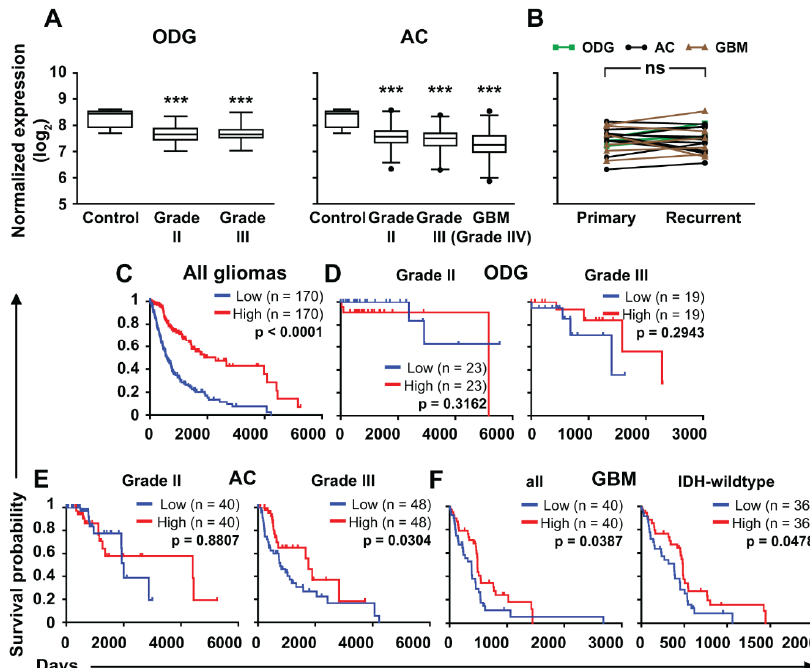
Figure 2. ZNF554 mRNA expression is decreased in gliomas and positively associates with patient survival. ( A ) Box plots (median and whiskers: 1–99 percentile) represent normalized gene expression levels (log 2 norm_count + 1) of ZNF554 from processed control brain ( n = 5), ODG (grade II, n = 93; grade III, n = 75, left graph ), AC (grade II, n = 161; grade III, n = 194), and GBM (grade IV, n = 159, right graph ) RNA-Seq data from the TCGA database. One-way ANOVA with Dunnett’s post hoc test (*** p < 0.001) was used to compare glioma groups with the control group. ( B ) In 20 cases ( n ODG = 3, n AC = 11, n GBM = 6), ZNF554 gene expression levels of primary and recurrent gliomas were